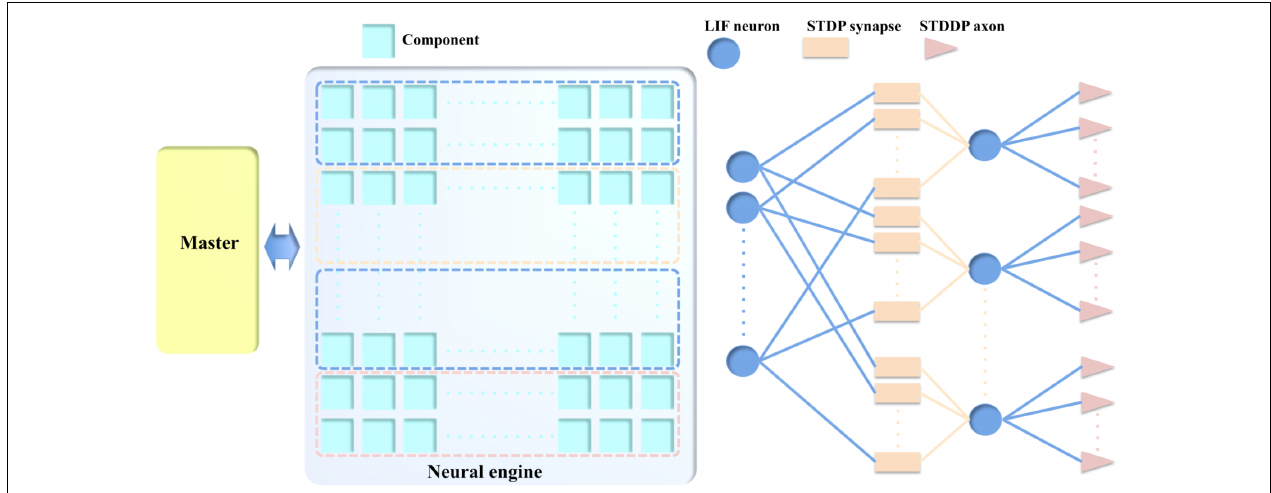
FIGURE 1 | The example usage of the components. In this example, one and only one type of components are configured as LIF neurons, STDP synapses, and STDDP axons. They are used to build the different part of the neural